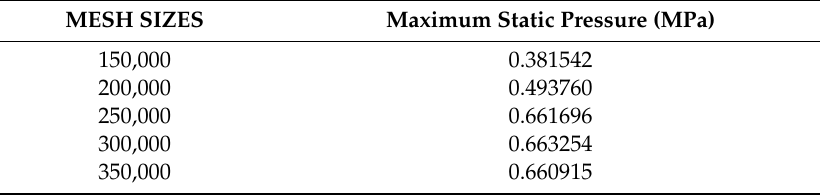
Table 3. Relationship between total number of computational cells and maximum static pressure.